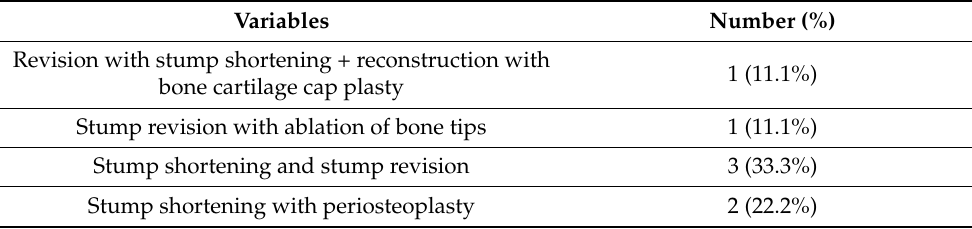
Table 2. Summary of the bony revision procedures that were performed in complicated amputated patients.